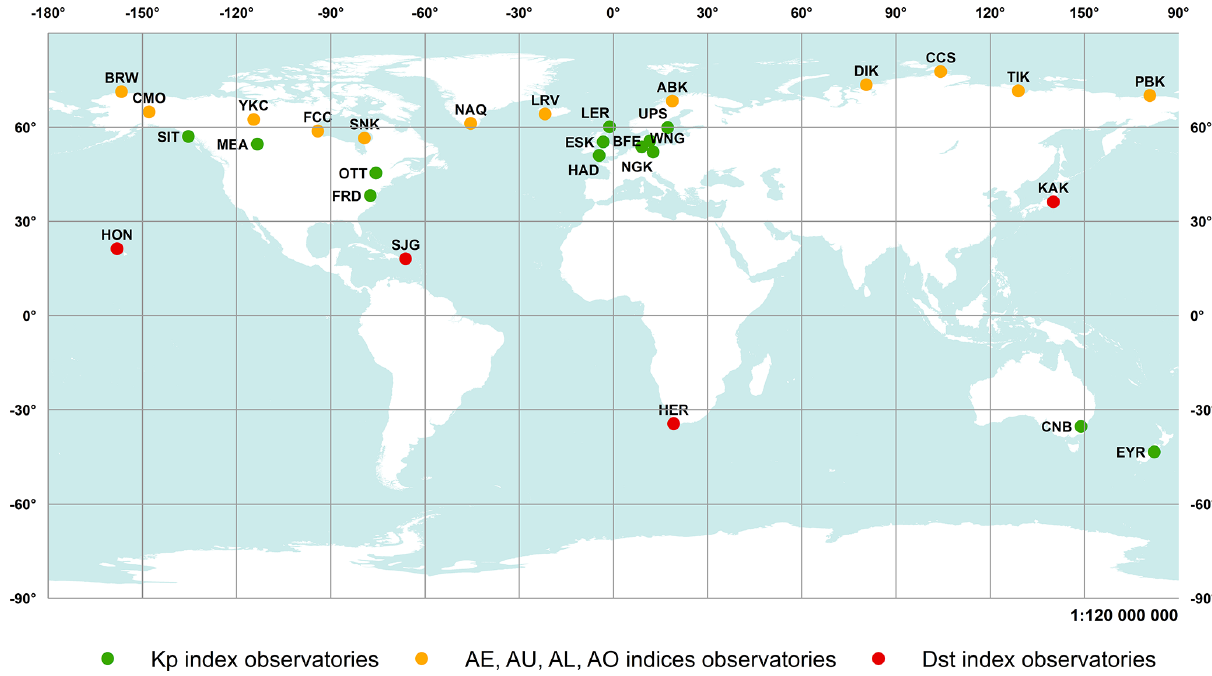
Figure 1. The map shows the observatories used for calculating the geomagnetic indices: Kp (green circles), AE, AU , AL , and AO (orange circles), and Dst (red